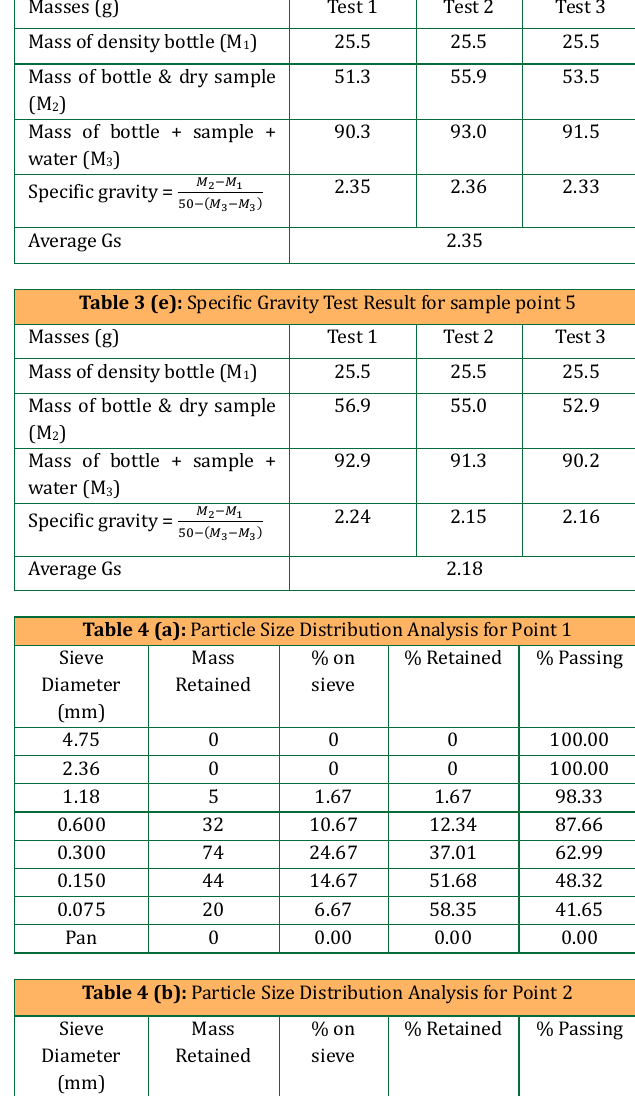
Table 2 (c): Moisture content test results for sample point 3 Test